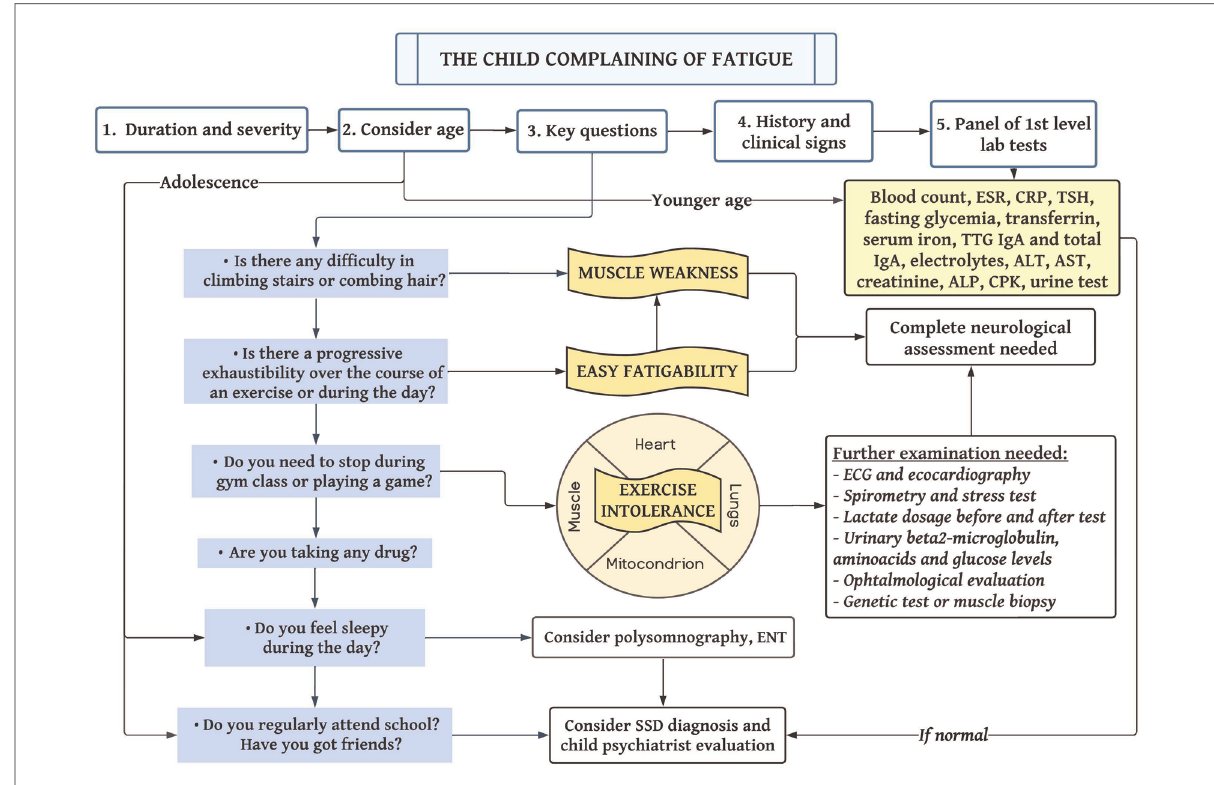
FIGURE 1 Proposal of a diagnostic fl owchart to assess the child complaining of fatigue . Abbreviations: ESR, erythrocyte sedimentation rate; CRP, C-reactive protein; TSH, thyroid-stimulating hormone; TTG, tissue transglutaminase; AST, aspartate transaminase; ALT, alanine aminotransferase; ALP, alkaline phosphatase; CPK, creatine phosphokinase; ECG, electrocardiogram; ENT, ear nose and throat; SSD, somatic symptom